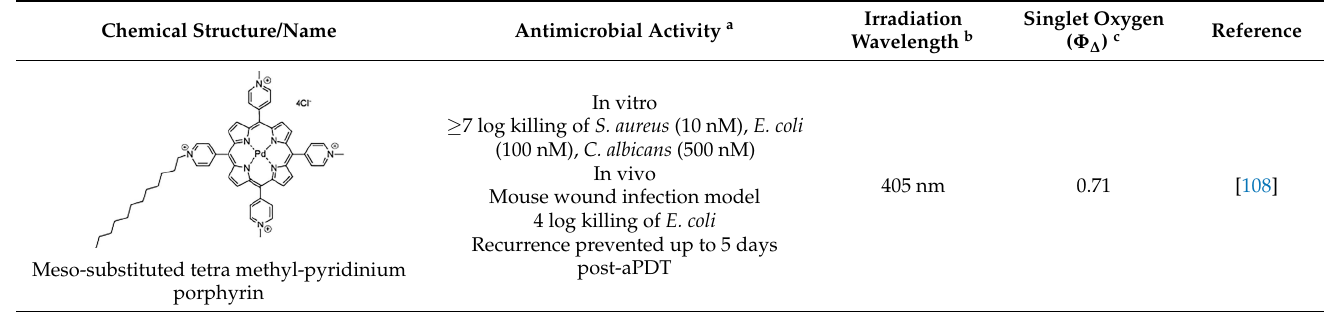
Table 1. Examples of novel photosensitisers with antimicrobial PDT activity in vitro and in vivo.